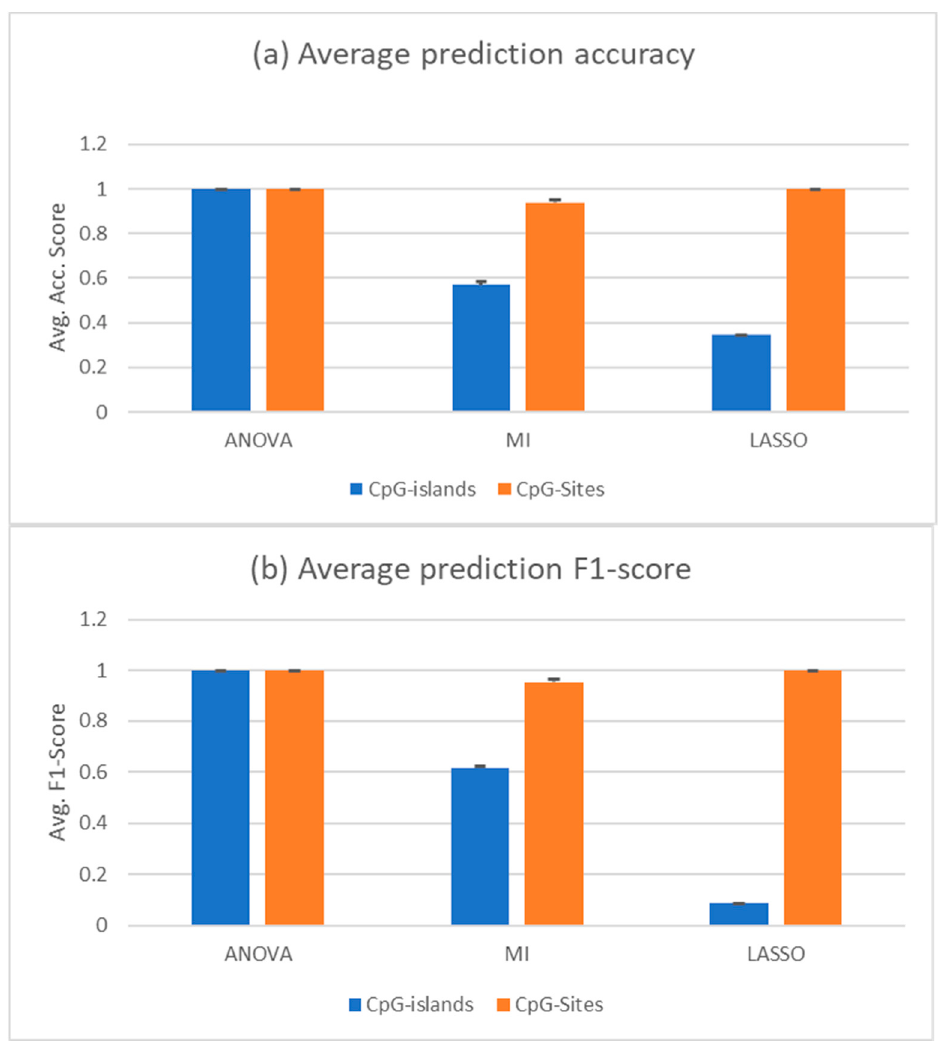
Figure 3. cfDNA classification based on random forest trained with all solid tumours and PBMC samples. The training set was limited to just the solid tumours and PBMC samples (35 and 37 samples, respectively). The selectors were trained only on solid tumour and PBMC samples as a randomly shuffled training set. The test set was composed of the healthy and cancerous cfDNA samples (10 and 22 samples, respectively). ( a ) Average prediction accuracy of the random forests trained with—and tuned on—the features selected by the indicated methods. ( b ) Average F1 score of the same predictions. Black bars are the standard deviation. Two PBMC samples were removed from the set, since they were outliers from the others in the PCA. CpG islands methylation (blue) or CpG sites (oranges) were used for the analysis.